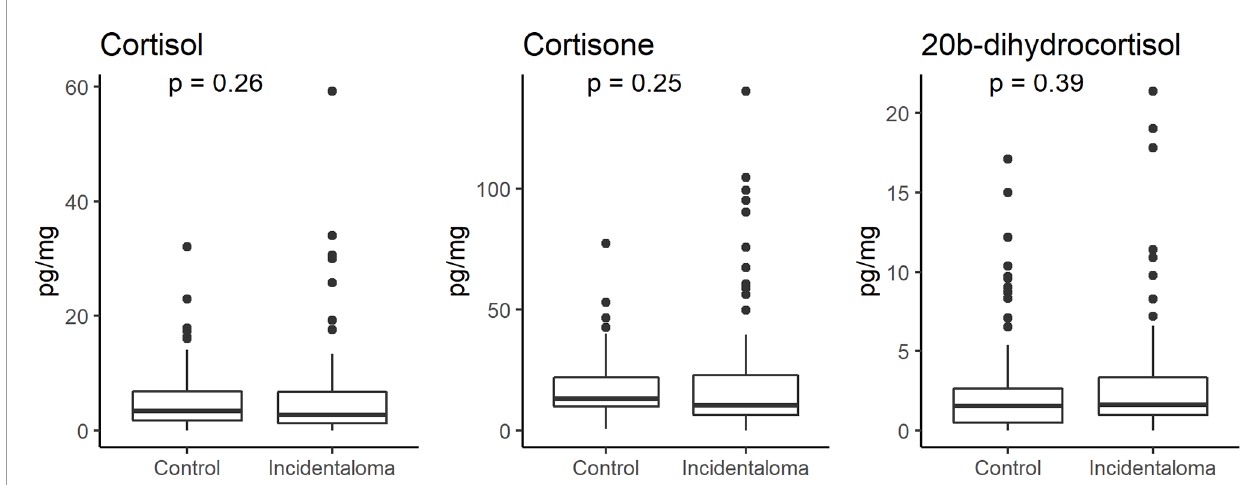
FIGURE 2 | Comparison of hair cortisol, cortisone, and 20 b -dihydrocortisol levels between healthy controls and patients with adrenal incidentaloma showing the lack of any signi fi cant difference.